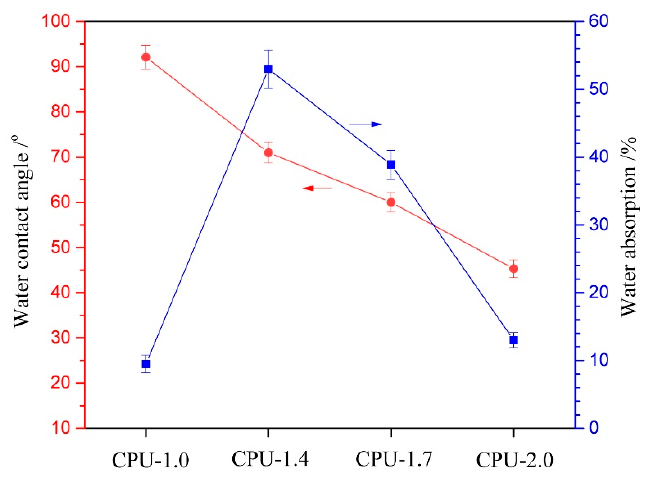
Figure 7. Water contact angle and water absorption of CPU films with different COS content.